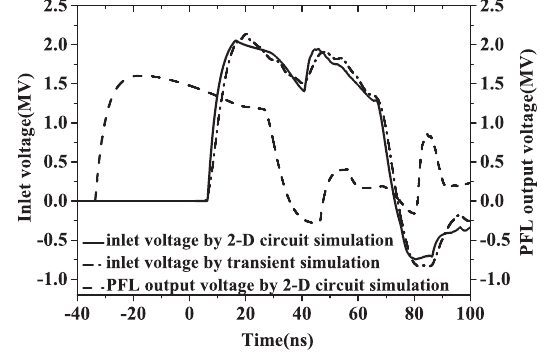
FIG. 5. The oil elbow inlet voltage waveforms acquired by 2D circuit simulation (black solid line) and transient electro- magnetic simulation (black dash-dotted line). The PFL output voltage obtained by 2D circuit simulation is also presented (black dashed line).